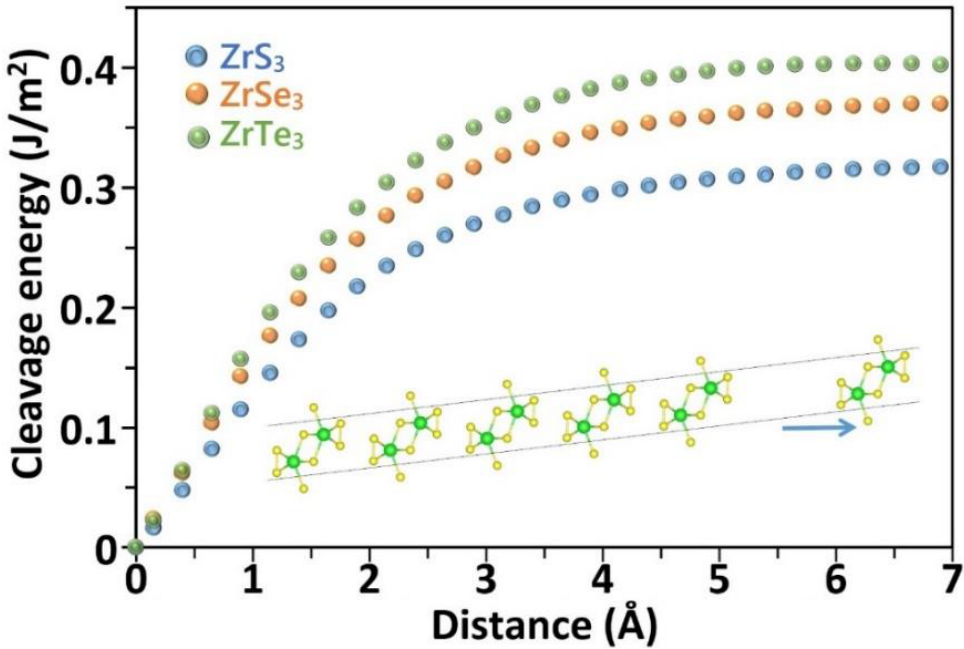
Figure 4. Cleavage energy of the ZrS 3 , ZrSe 3 , and ZrTe 3 monolayers as a function of separation distance.